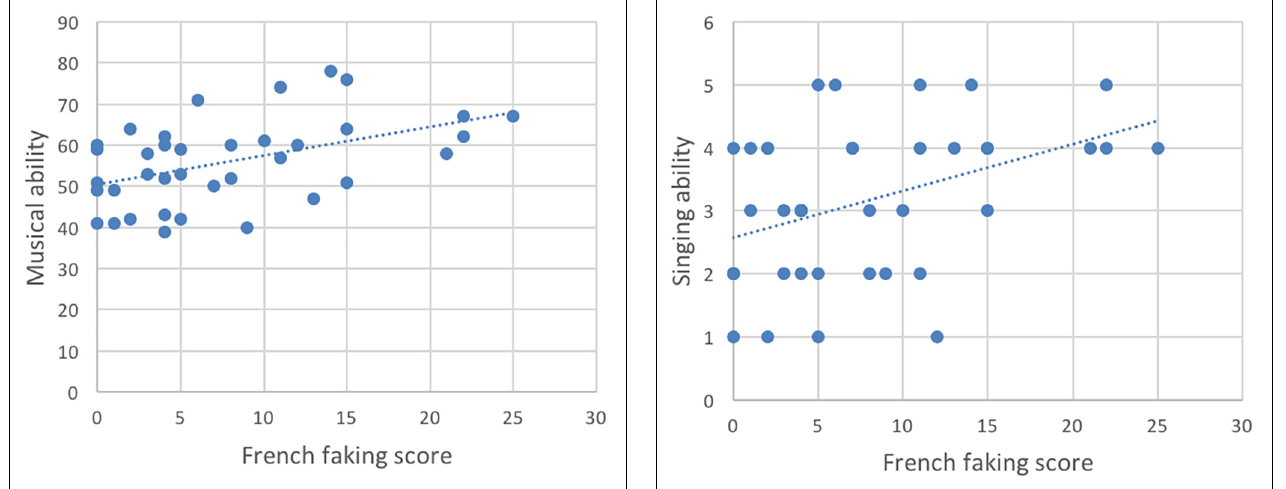
FIGURE 2 | Correlation of speakers’ singing ability with the French faking scores.